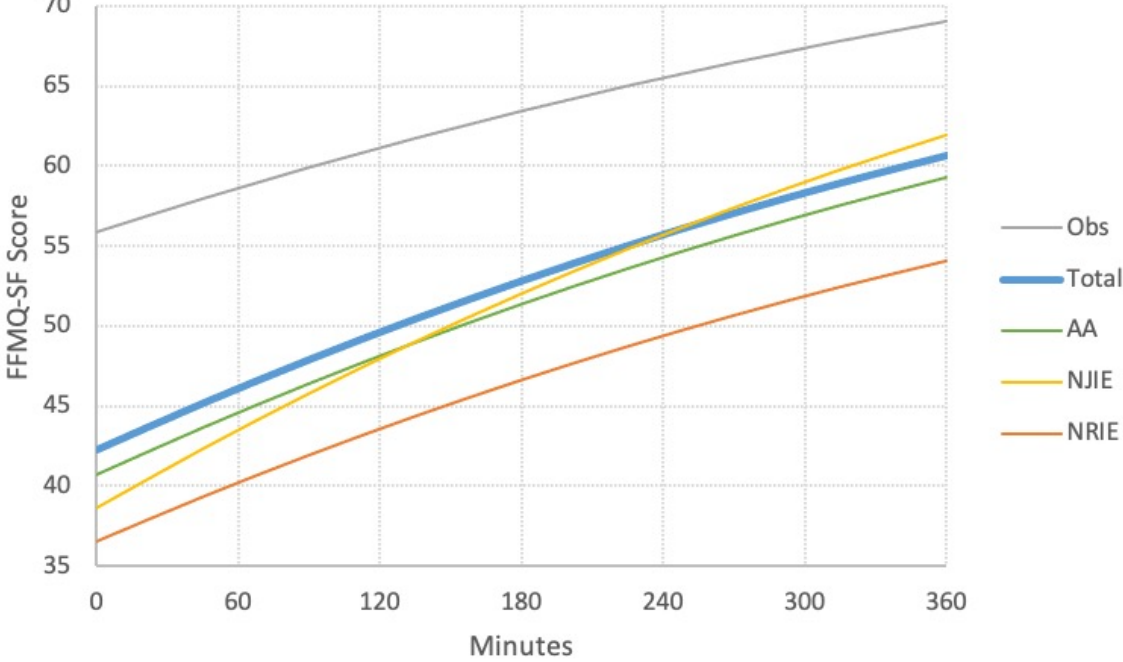
Figure 2. Association between duration of app use and being observant (Obs), acting with awareness (AA), nonjudging of inner experience (NJIE), and nonreactivity to inner experience (NRIE). FFMQ-SF: Five-Facet Mindfulness Questionnaire-Short